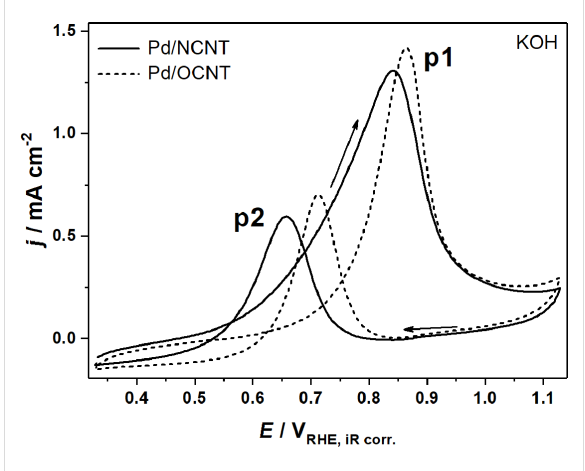
Figure 1: CVs of the electrooxidation of 1 M glycerol over Pd/NCNT and Pd/OCNT in 1 M KOH at 1000 rpm at a scan rate 0.01 V s − 1 .